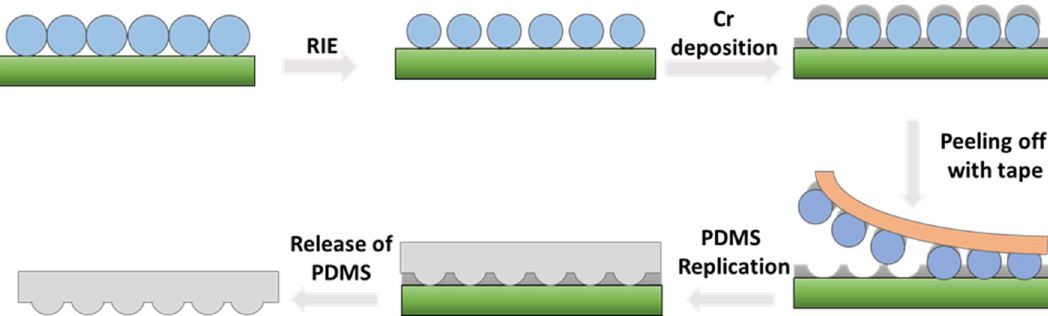
Figure 1. Schematic illustration of the fabrication process for mold and sensor. Nanoparticles were assembled on a silicon substrate then they were etched with RIE process. Metal (Cr) film was deposited in the gap between the particles so that concave structures were fabricated after peeling off the particles. The mold with nano- concave structures were used to fabricate sensor substrate with nano-convex